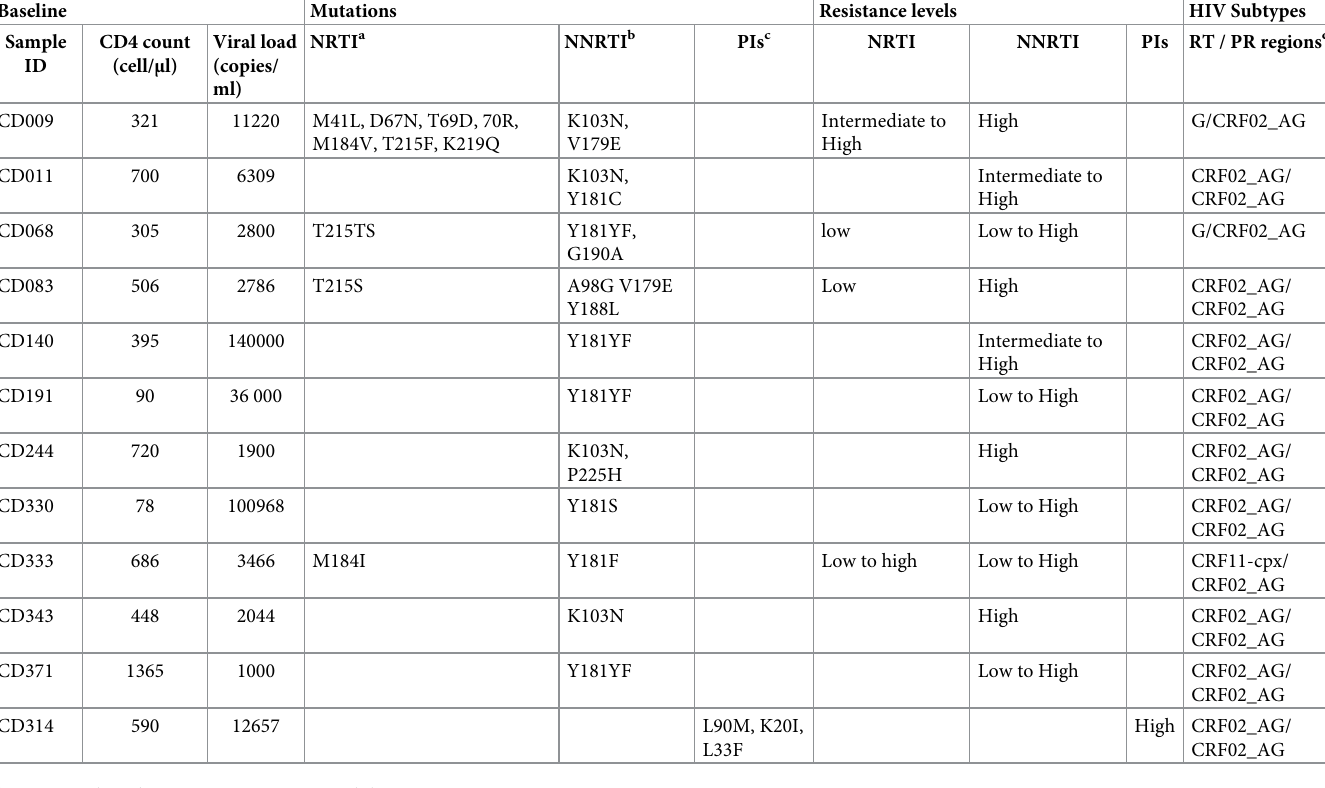
a NRTI: Nucleoside Reverse Transcriptase Inhibitors b NNTI: NoNucleoside Reverse Transcriptase Inhibitors c PIs : Protease Inhibitors